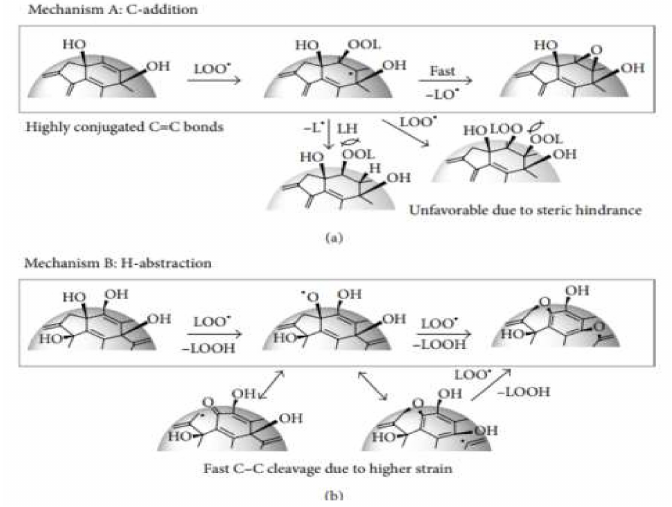
Figure 7. Possible mechanism of β -Carotene bleaching assay. ( a ) Mechanism A: C-addition, ( b ) Mech- anism B: